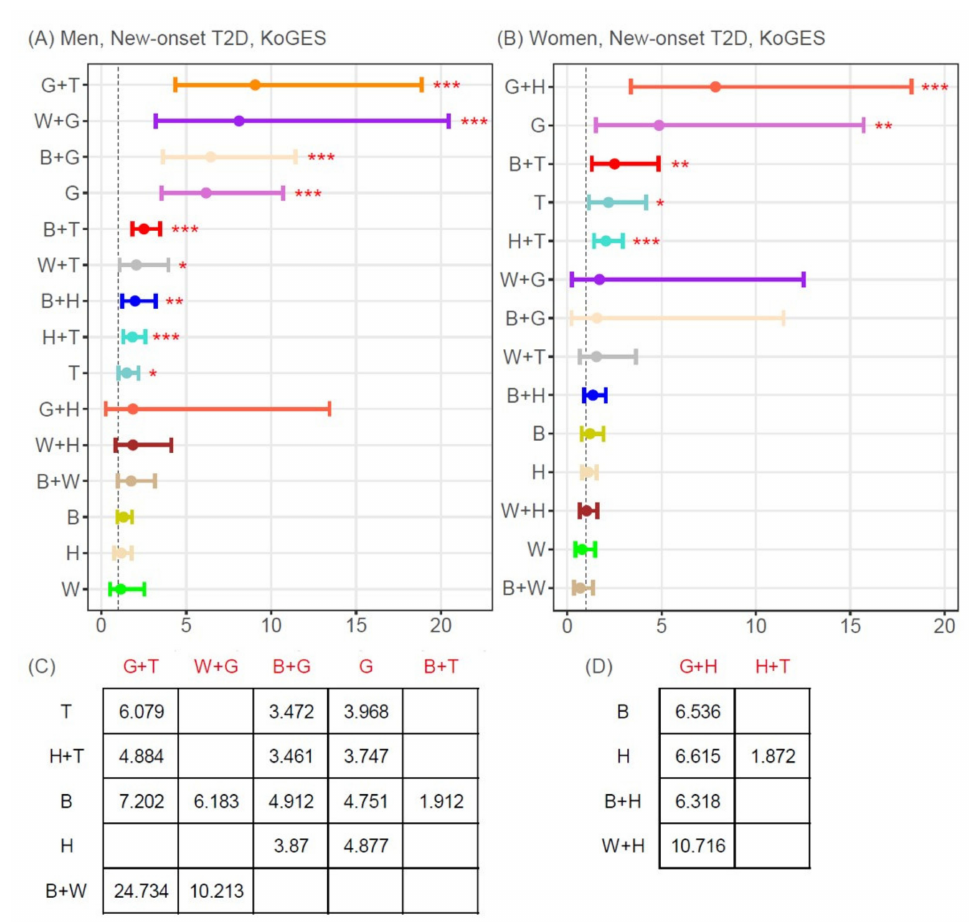
Figure 3. Adjusted hazard ratios and 95% confidence intervals for new-onset type2 diabetes. ( A , C ) men, ( B , D ) women. ( A , B ) Hazard ratios and 95% confidence intervals for the risk of new-onset type 2 diabetes of each single MetSyn component and two-component combination, compared with non-MetSyn, based on multivariate Cox regression analysis after adjusting for age, body mass index, smoking, and alcohol intake. Closed circles represent adjusted hazard ratios, and short vertical bars indicate the lower and upper limits of the 95% confidence interval for new-onset type 2 diabetes. ( C , D ) Adjusted hazard ratios for new-onset type 2 diabetes when setting the rows (black color; e.g., T, H+T, B]) and columns (red color; e.g., G+T, W+G, B+G) as reference and comparison groups, respectively. Of the 105 possible unique comparisons (based on a 15 × 15 matrix), adjusted hazard ratios are shown for only those comparisons with a Bonferroni-corrected p -value < 4.79 × 10 − 4 (=0.05/105). * p < 0.05, ** p < 0.01, *** p < 0.001. B, elevated blood pressure; G, elevated glucose; H, low HDL-cholesterol; KoGES, Korean Genome and Epidemiology Study Ansan and Ansung; MetSyn, metabolic syndrome; T, elevated triglycerides; T2D, type 2 diabetes; W, increased waist